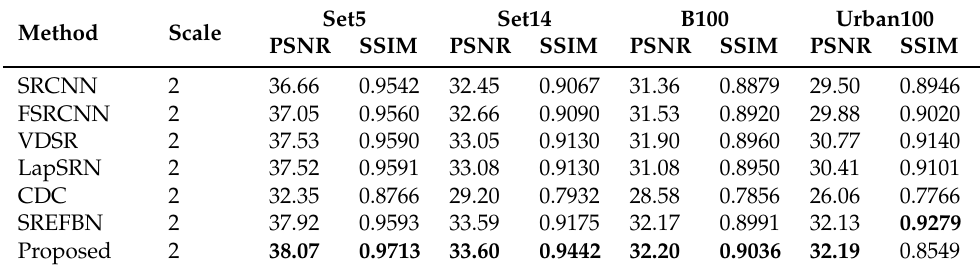
Table 1. Quantitative comparison of 2 × super-resolution results obtained by different methods.